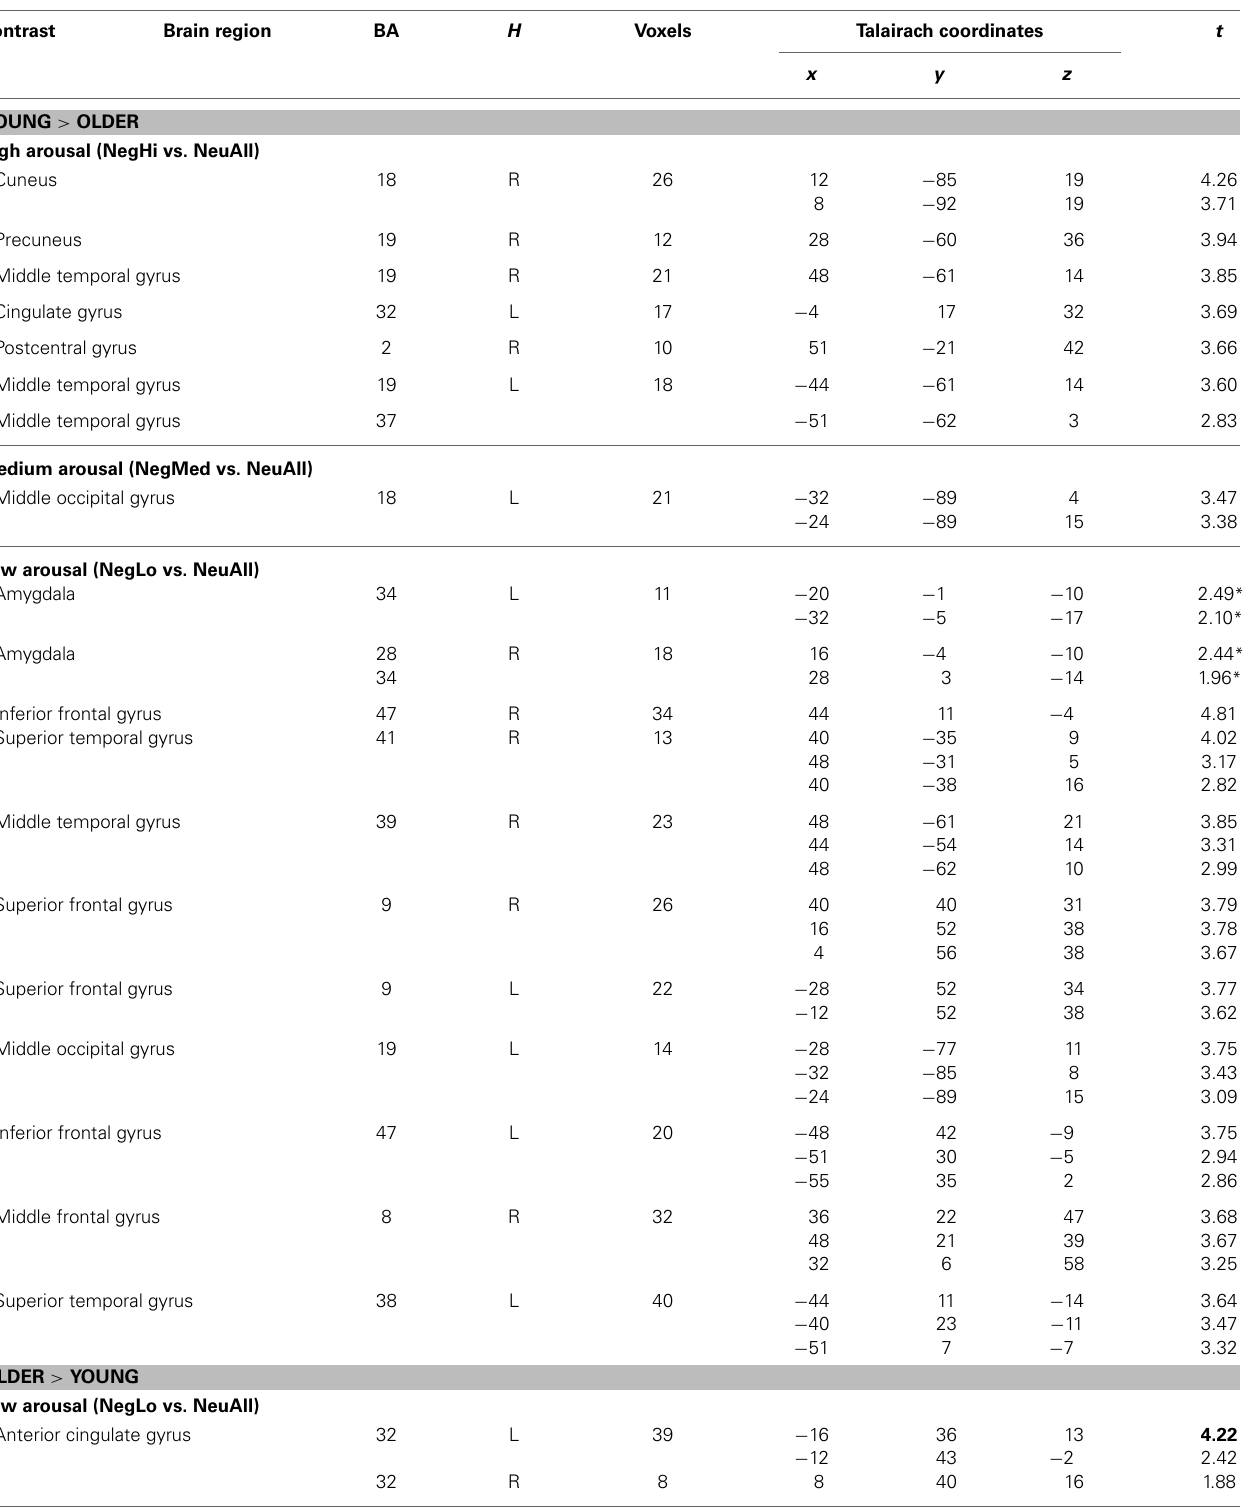
Table 4 | Dissociable brain activity for negative vs. neutral stimuli by arousal levels in young and older adults. Contrast Brain region BA H